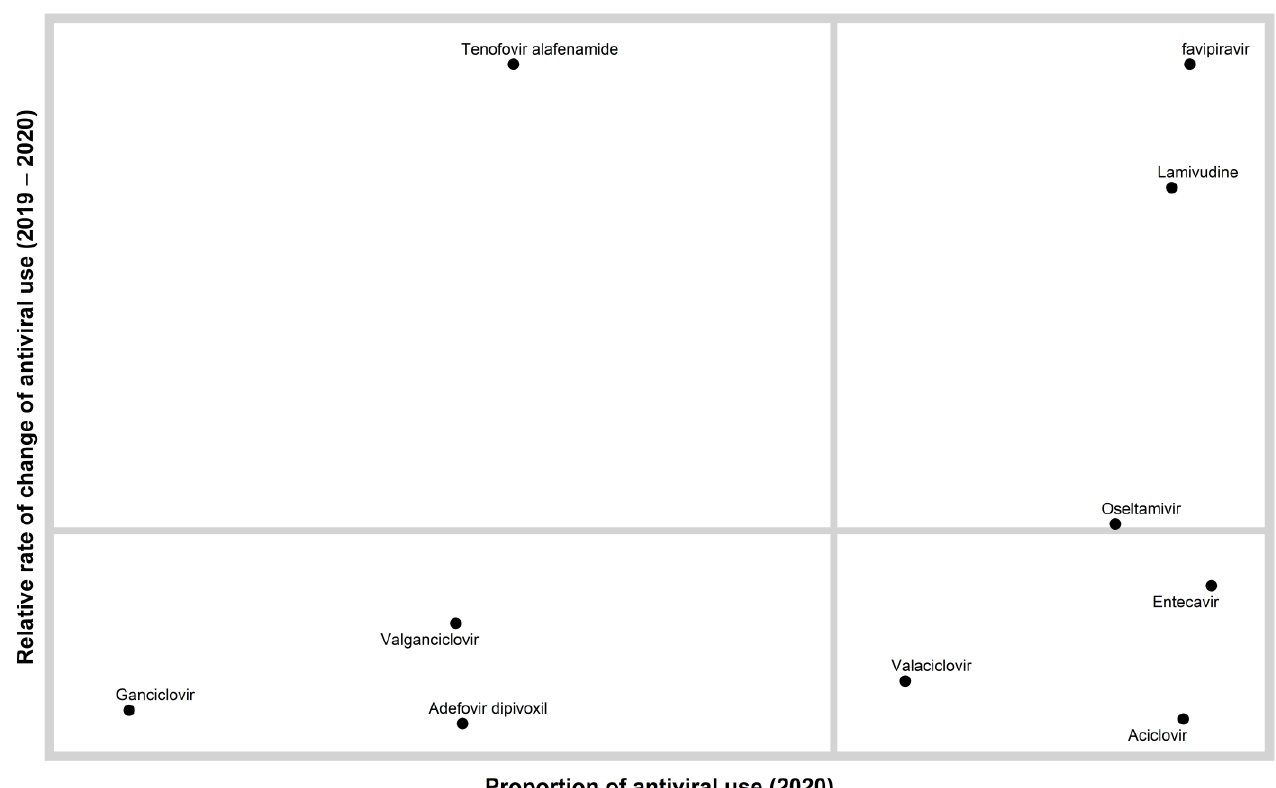
Figure 2. A quadrant chart showing the distribution of antiviral agents according to the rate of change of antiviral use (2019 – 2020), and the proportion of antiviral use in 2020. This chart enables a relative comparison of both antiviral levels and trends. We can consider the antivirals in the lower right quadrant as widely dispensed but at a lower rate than the previous year. We can consider the upper right quadrant as widely dispensed but at a higher rate than the previous year. The upper right quadrant contains antivirals that are candidates for further evaluation.